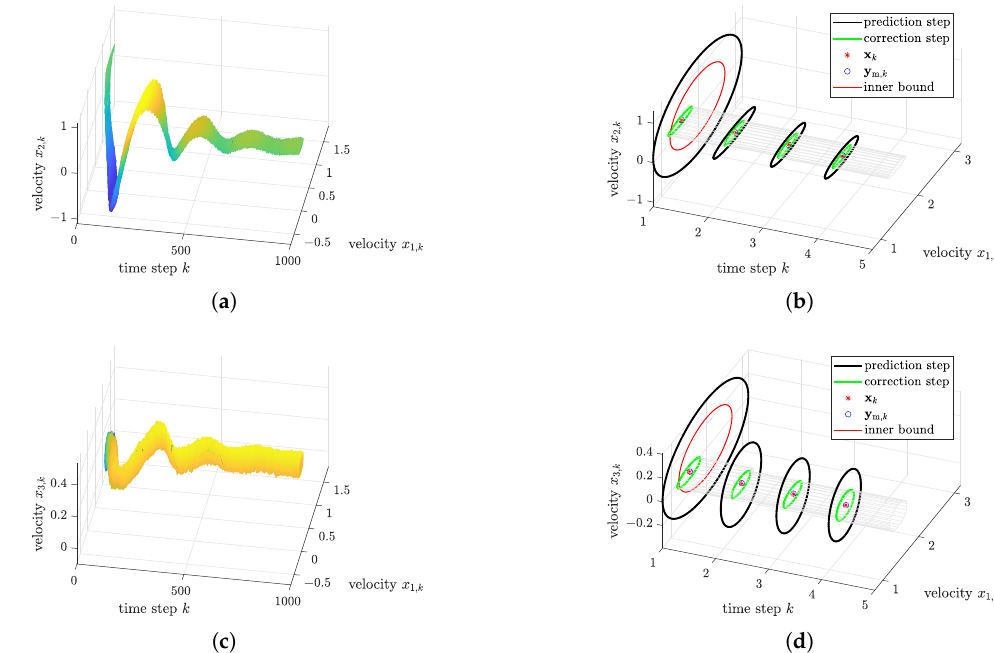
Figure 11. State estimation for the case of small uncertainties (92). ( a ) Outer ellipsoidal enclosures for the velocities x 1, k and x 2, k . ( b ) Enlarged view of the ellipsoidal enclosures of x 1, k and x 2, k . ( c ) Outer ellipsoidal enclosures for the velocities x 1, k and x 3, k . ( d ) Enlarged view of the ellipsoidal enclosures of x 1, k and x 3, k